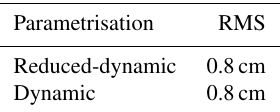
Table 3. K-band RMS using covariances over 50min in the orbit reconstruction for April